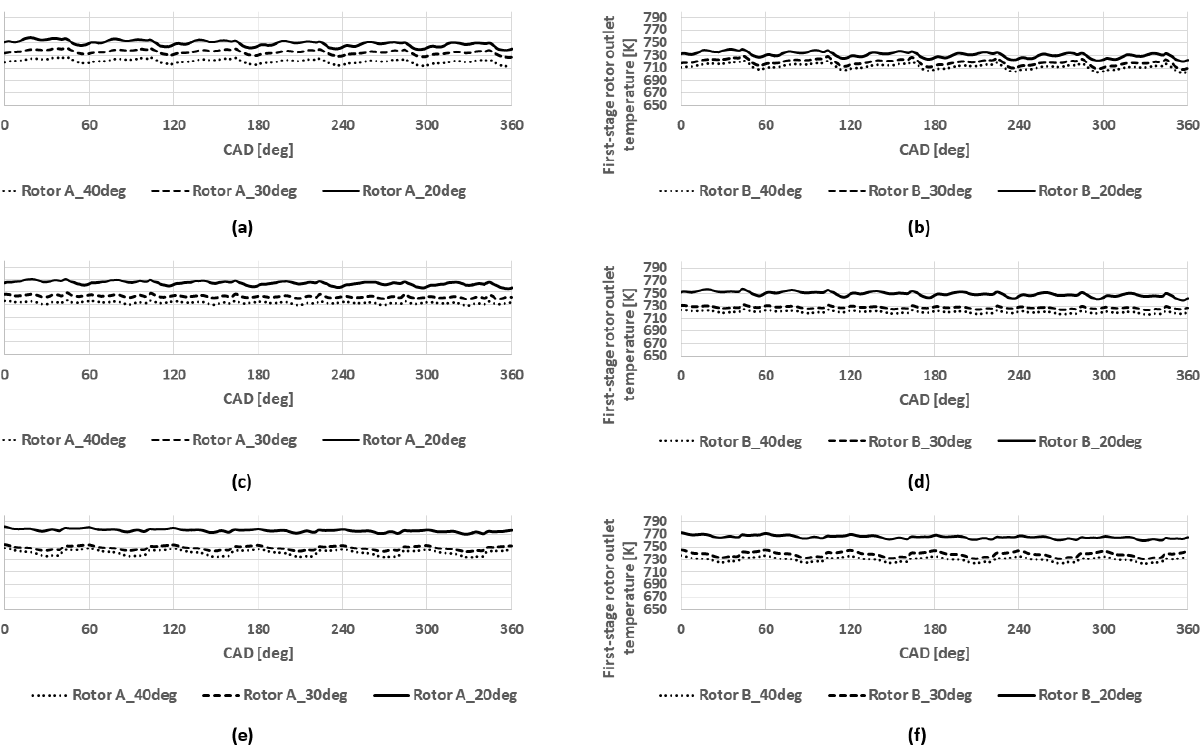
Figure 24. The variation of area-averaged total temperature at the outlet from the first-stage rotor during the single revolution of the crankshaft for three different turbine speeds, VTG vane positions and rotor geometries: ( a ) rotor A at 60,000 rpm, ( b ) rotor B at 60,000 rpm, ( c ) rotor A at 50,000 rpm, ( d ) rotor B at 50,000 rpm, ( e ) rotor A at 40,000 rpm, ( f ) rotor B at 40,000 rpm. Table 9. The average temperature drop at the first-stage rotor for two different rotor geometries, three turbine speeds and VTG positions.